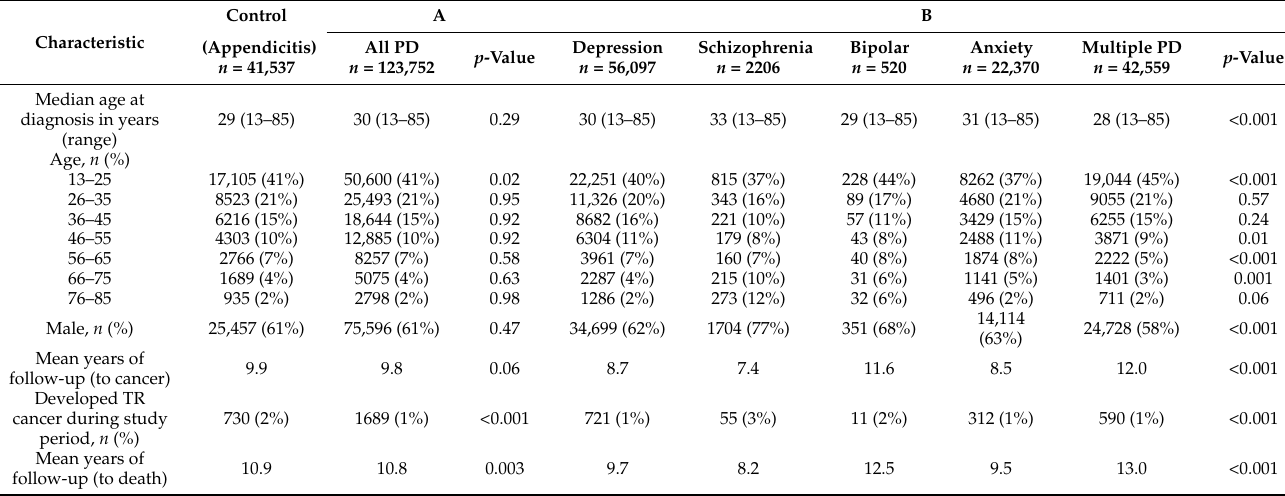
Table 1. Matched cohort demographics and follow-up information, comparing all psychiatric disorders and psychiatric disorder sub-cohorts to the appendicitis control